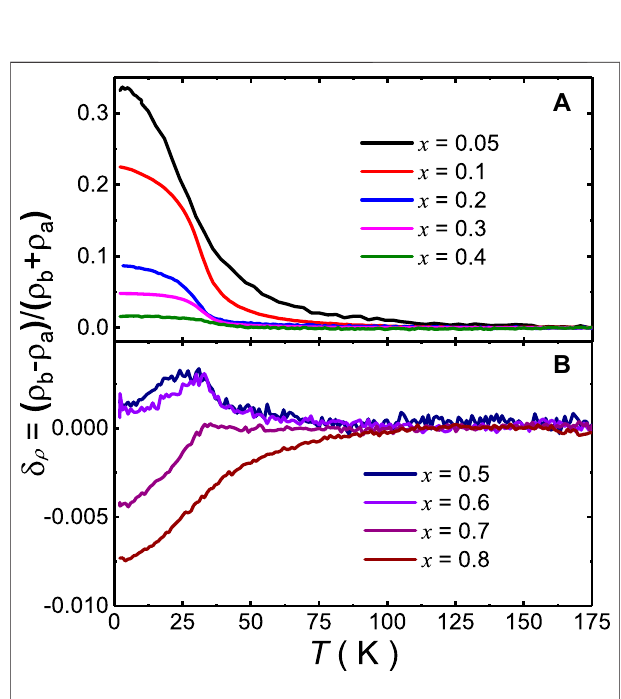
FIGURE 3 | (Color online) Temperature dependence of the in-plane resistivity anisotropy δ ρ from x = 0.05 to 0.8. (A) In electron-type compounds, δ ρ gets weaker but keeps positivewhen increasing Cr doping. (B) In hole-type compounds, δ ρ is very weak and becomes negative when x ≥ 0.7.